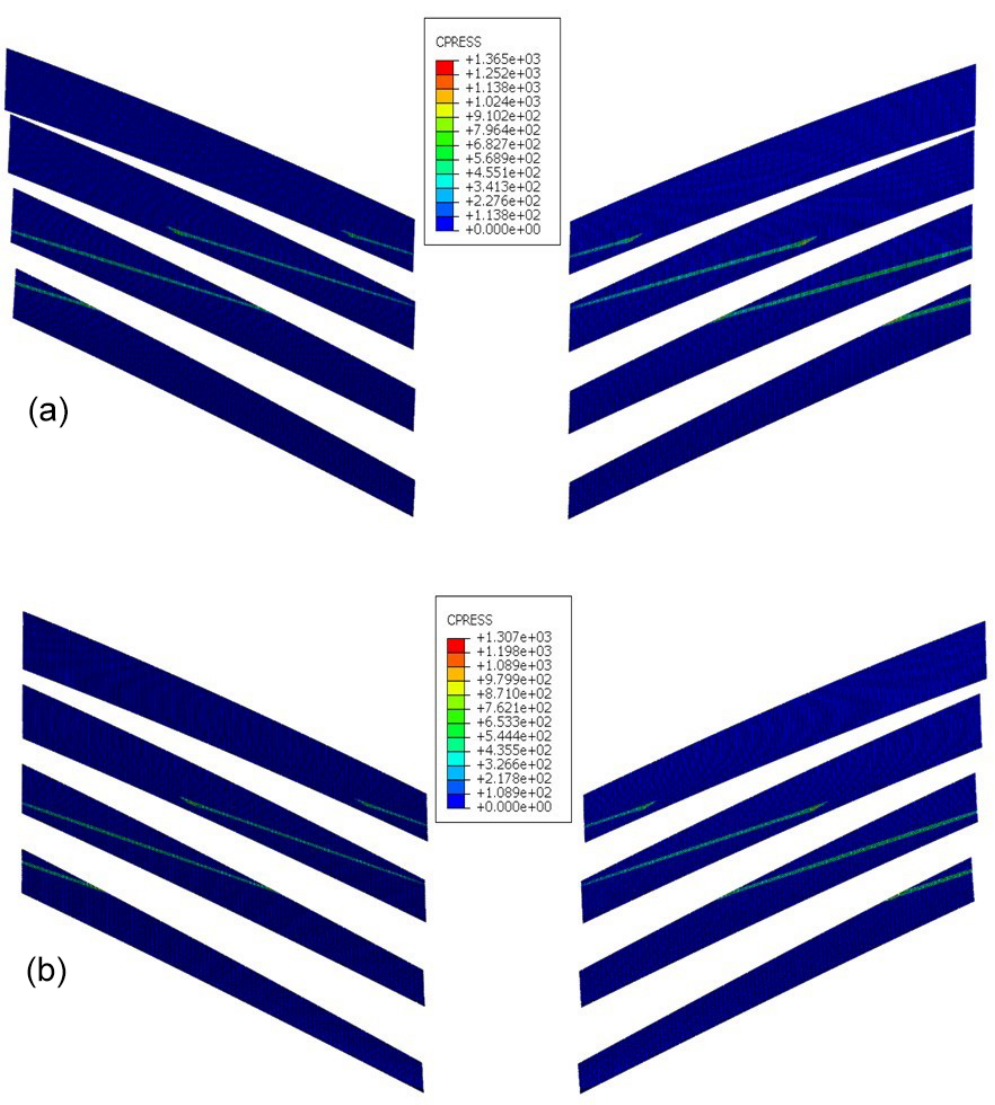
Figure 13. Cloud diagram of tooth meshing contact stress with different power flow directions. (a) U -shaped power flow direction tooth meshing contact stress cloud. (b) Z -shaped power flow direction tooth meshing contact stress